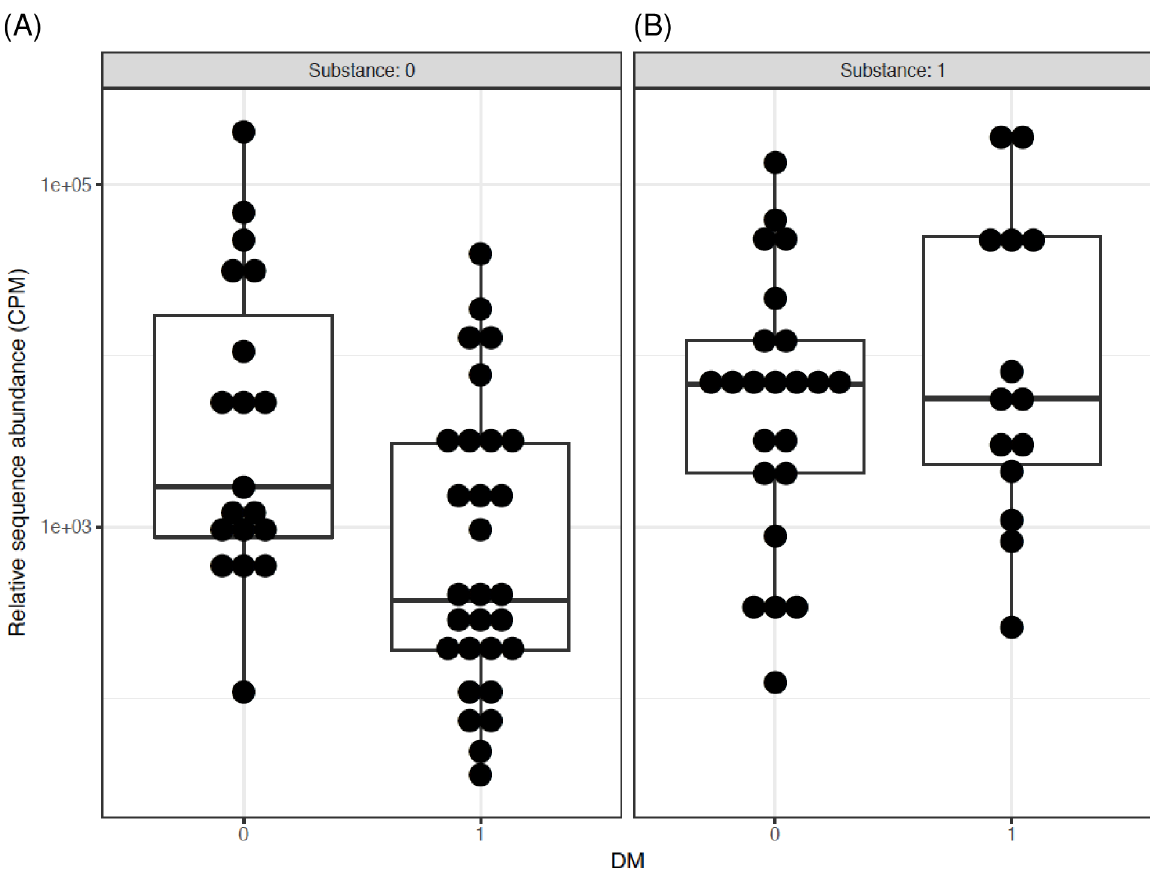
Fig 3. The interactive influence of T2D on Bifidobacterium genus in men using or not using opioids. Data are pair-wise comparisons for the relative sequence abundance of Bifidobacterium . The differential subgroup analysis was done using edgeR, the false discovery rate (FDR) adjusted p values (q values) were calculated using the Benjamini-Hochberg FDR correction. Abbreviations: 0/1 = factor absent/present. CPM = count per million, DM = type 2 diabetes, Substance = opioids. (A) 2.3 log2 fold decrease in subjects with vs. without T2D when both groups are not using opioids (q = 0.03). (B) No difference between without vs. with T2D when both groups are using